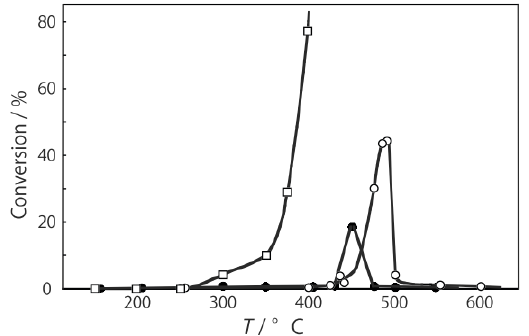
Figure 13. Effect of preliminary activation temperature on catalytic activity of (H O) [(W Cl )Cl ]·6H O. Following the activation of the cluster (30 mg, 17 μmol) 3 2 6 8 6 2